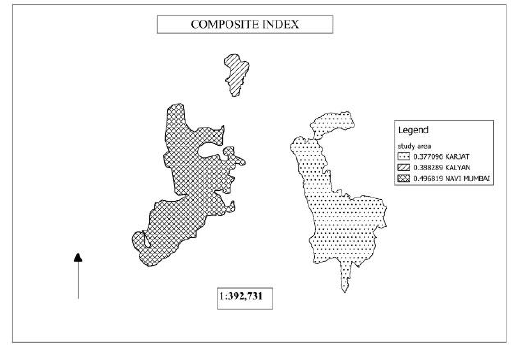
Figure 5 : Liveability